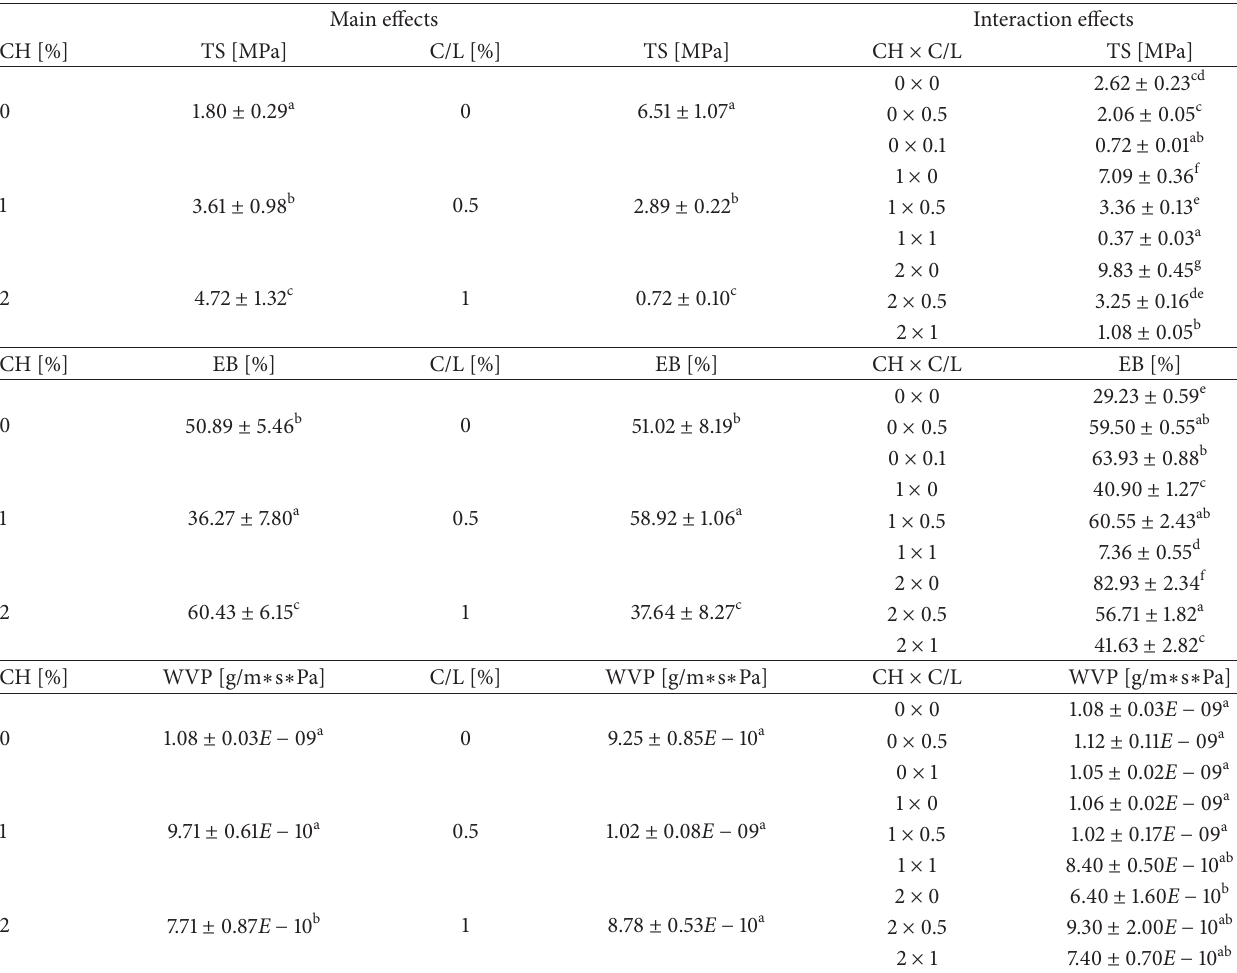
Table 2: Mechanical properties of